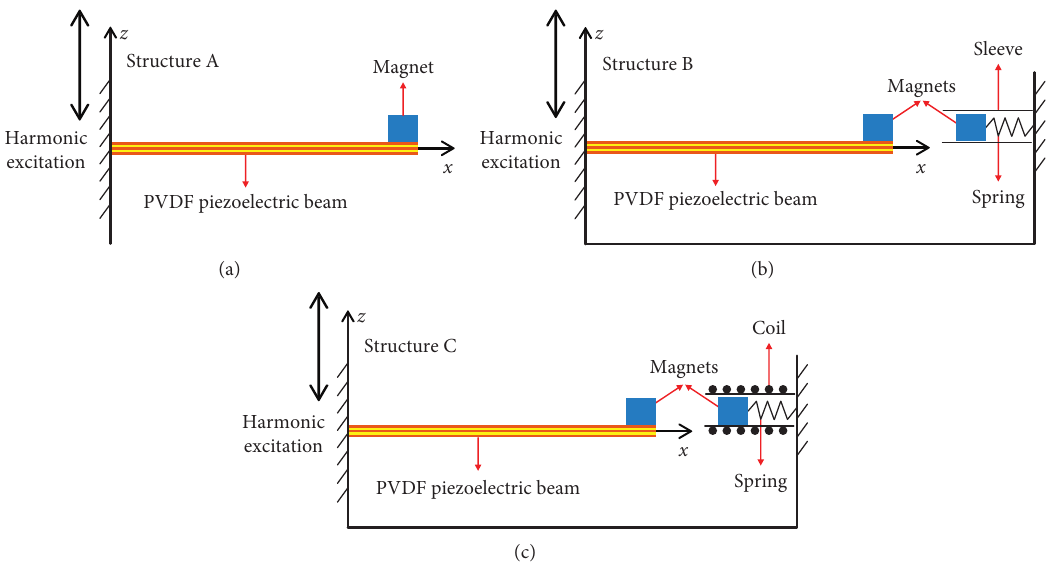
Figure 7: Three kinds of structures: (a) structure A; (b) structure B; (c) structure